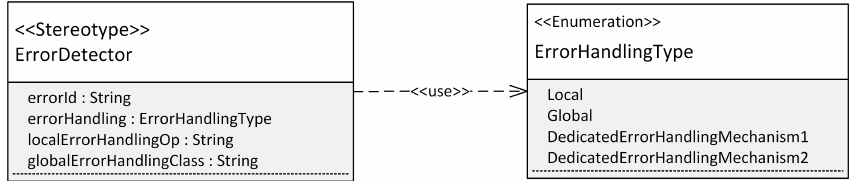
Figure 10. The SafetyGenBasic profile (UML 2.5 profile diagram